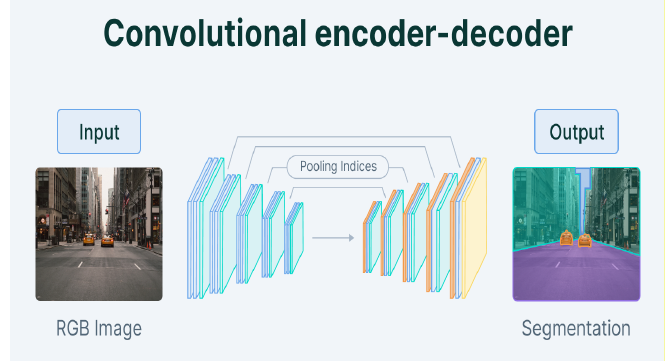
Figure 1. Schematic Representation of the Auto-Encoder.